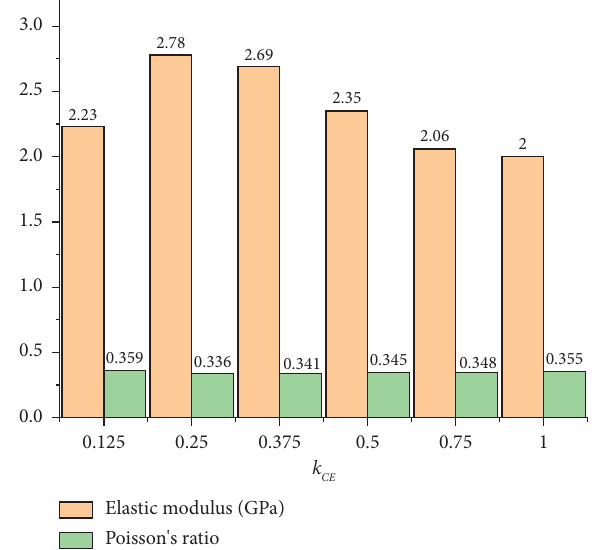
Figure 19: UCS and peak strain of epoxy resin with a k and various k A values.